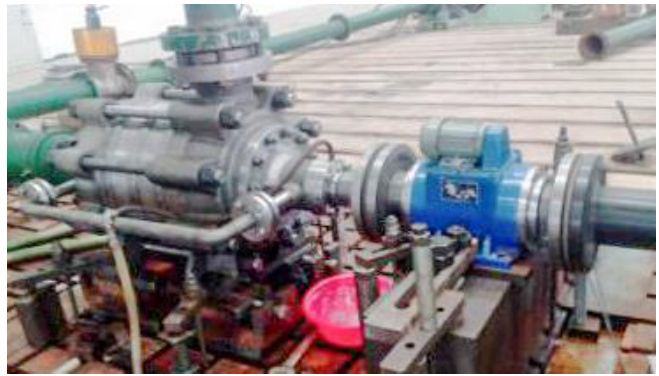
Figure 6. Test site diagram.